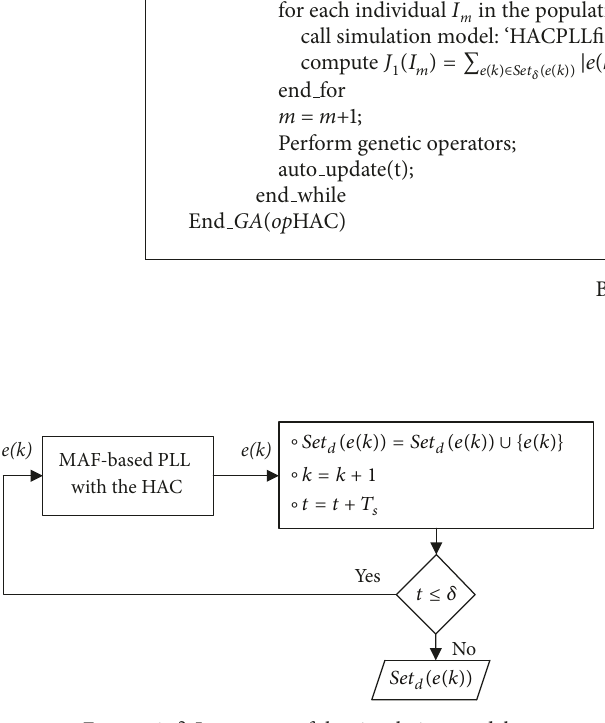
Figure 9: 𝛿 -Loop opHAC of the simulation